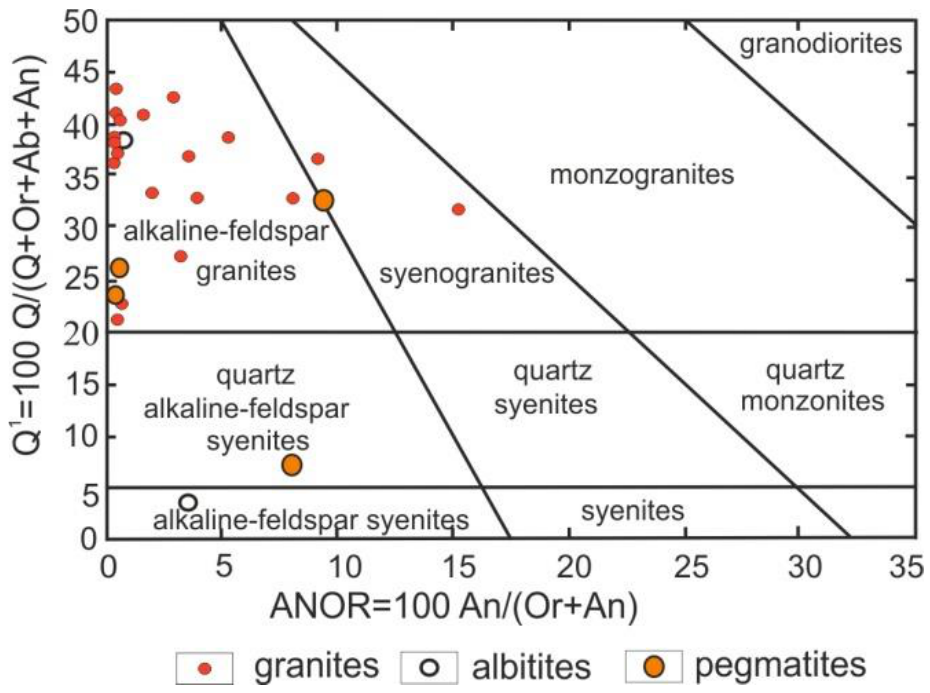
Figure 10. Classification diagram (after [56]) for rocks of the Somnitelnyi massif and Tommot de-